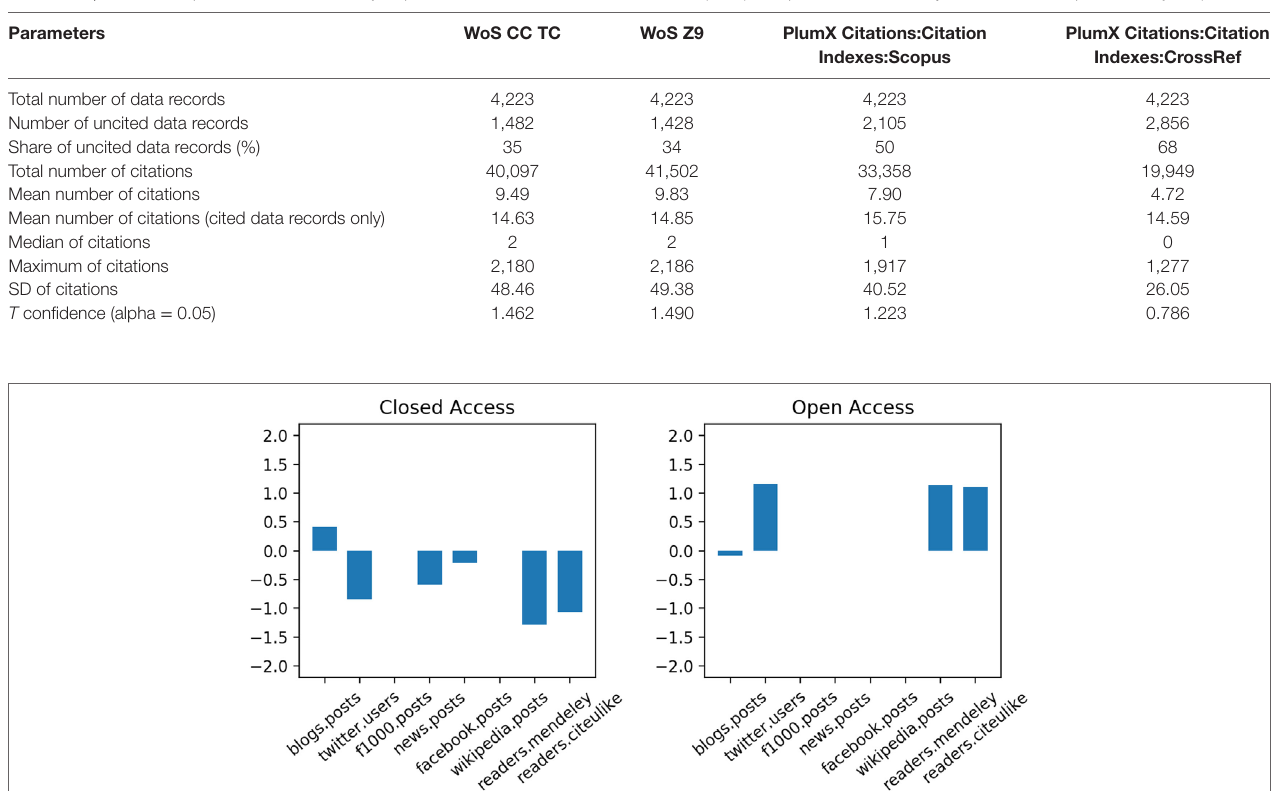
Table 10 | Statistical report for the citation analysis performed in WoS CC, Web of Science (WoS), Scopus, and CrossRef (journal articles; all publication years).